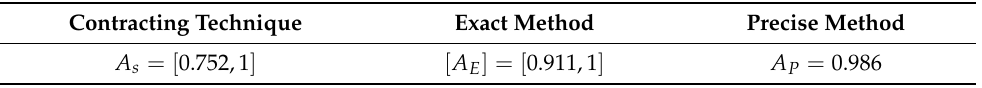
Table 5. The system’s availability obtained by different